Question: Briefly state, in one sentence, what is plotted here.
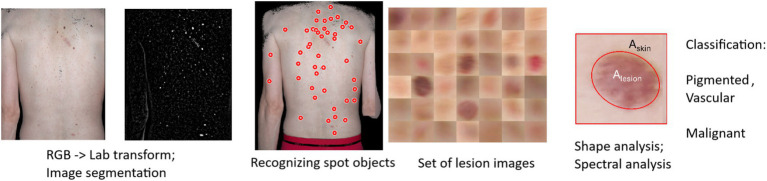
Answer: Lesion image processing steps to analyze large multi-lesion skin areas of human body ( 12 ).